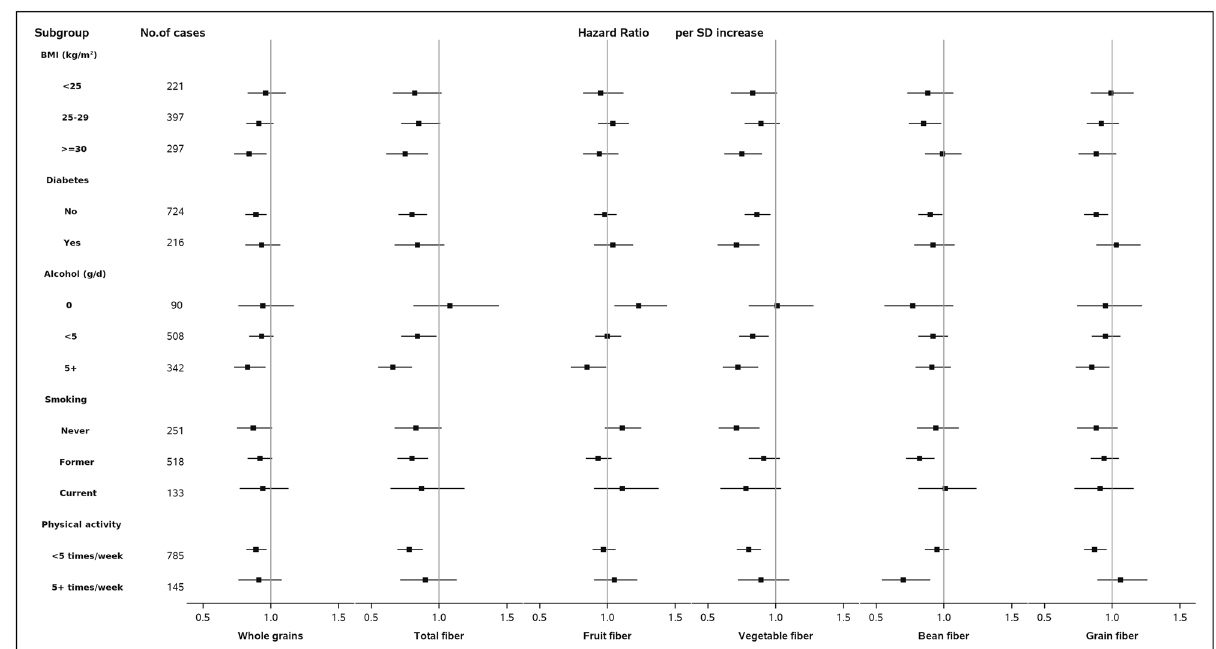
Fig. 1 Strati fi ed analyses for association between whole grain and dietary fi ber intake with risk of liver cancer among the participants of NIH – AARP Diet and Health Study. Cox proportional hazard regression models were used. All P -values were two-sided. Models were strati fi ed by sex and adjusted for age at baseline (continuous), level of education ( ‘ ≤ 11 years ’ , ‘ high school ’ , ‘ vocational technology school ’ , ‘ some college ’ , ‘ college/postgraduate ’ ), race ( ‘ non-Hispanic white ’ , ‘ non-Hispanic black ’ , ‘ Hispanic ’ , ‘ Asian, Paci fi c Islander, or American Indian/Alaskan native ’ ), BMI ( ‘ < 25 ’ , ‘ 25 – 30 ’ , ‘ 30 + ’ kg/m 2 ), alcohol use ( ‘ Non-drinker ’ , ‘ 0.1 – 4.9 ’ , ‘ 5 – 9.9 ’ , ‘ 10 + ’ g/day), tobacco smoking ( ‘ never smoked ’ , ‘ former smoker ’ , ‘ current smoker ’ ), physical activity ( ‘ never ’ , ‘ rarely ’ , ‘ 1 – 3 time per month ’ , ‘ 1 – 2 times per week ’ , ‘ 3 – 4 times per week ’ , ‘ 5 + times per week ’ ), history of diabetes ( ‘ no ’ , ‘ yes ’ ) and total energy intake (continuous), except when the variable is used for strati fi cation. The P for interaction between whole grain or fi ber intake and characteristics for strati fi cation in risk of liver cancer were as follows: Whole grain: 0.22 for BMI, 0.25 for diabetes, 0.20 for alcohol use, 0.42 for smoking, and 0.98 for physical activity. Total fi ber: 0.87 for BMI, 0.18 for diabetes, 0.02 for alcohol use, 0.76 for smoking, and 0.53 for physical activity. Fiber from fruits: 0.71 for BMI, 0.36 for diabetes, <0.01 for alcohol use, 0.41 for smoking, and 0.29 for physical activity. Fiber from vegetables: 0.68 for BMI, 0.54 for diabetes, 0.05 for alcohol use, 0.37 for smoking, and 0.57 for physical activity. Fiber from beans: 0.15 for BMI, 0.33 for diabetes, 0.35 for alcohol use, 0.63 for smoking, and 0.02 for physical activity. Fiber from grains: 0.69 for BMI, 0.02 for diabetes, 0.44 for alcohol use, 0.51 for smoking, and 0.23 for physical